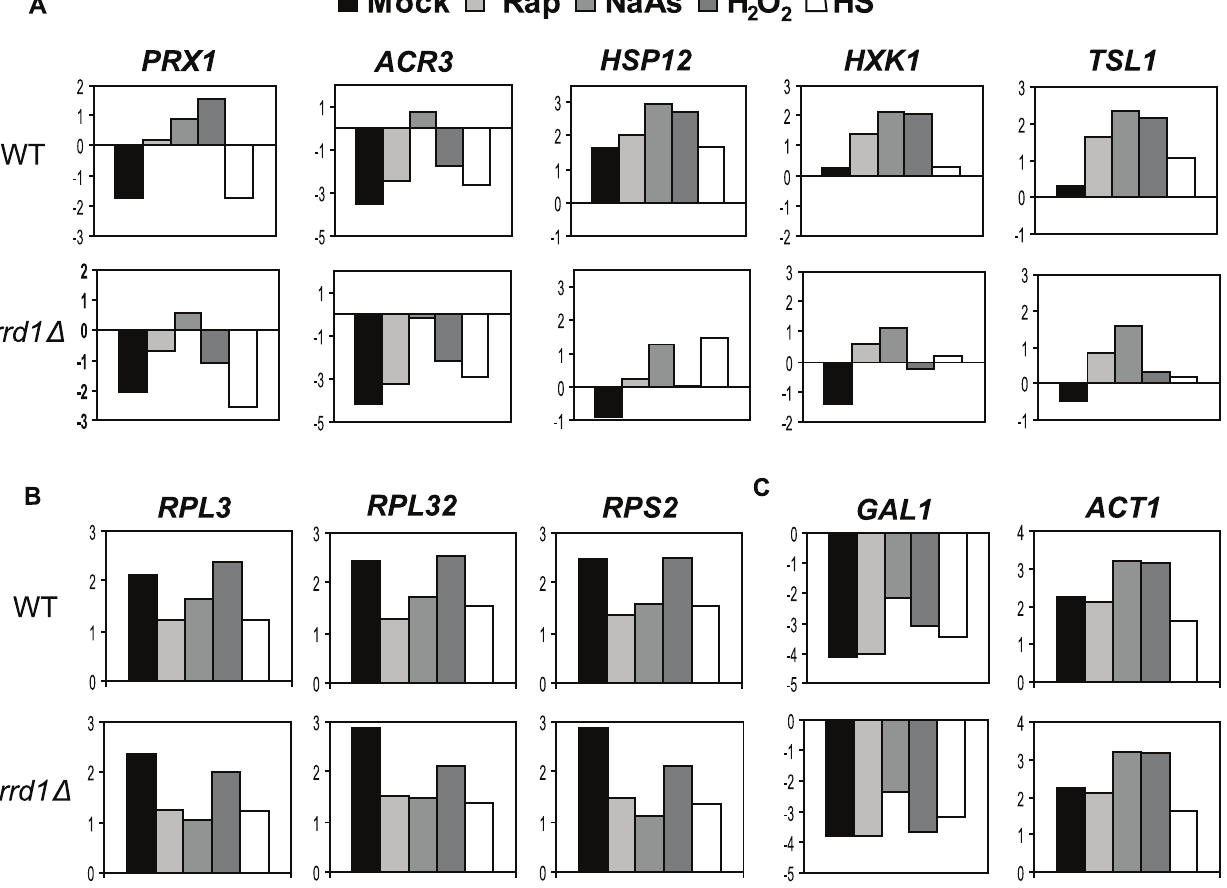
Figure 7. mRNA expression analyses in response to different stress conditions. GeXP multiplex expression analysis of 10 genes from untreated, rapamycin (100 ng/ml for 30 min), H 2 O 2 (0.6 mM for 30 min), NaAs (1 mM for 30 min), heat shock (37 u C for 30 min) treated conditions. The data is expressed in log 2 ratio and is calculated relative to an internal PCR control. ( A ) Five upregulated genes. ( B ) Three downregulated genes ( C ) Two control genes.